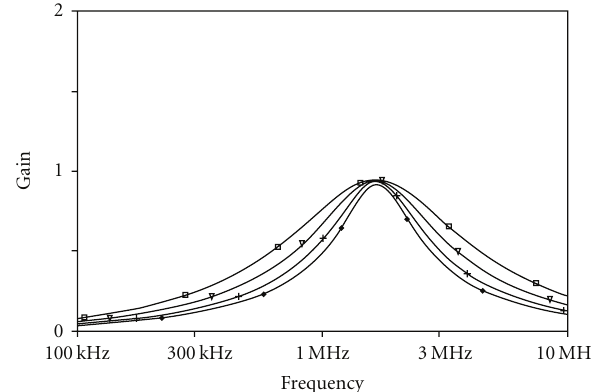
Figure 8: Response of band-pass filter for constant f 0 = 1 . 59 MHz and di ff erent Q 0 .